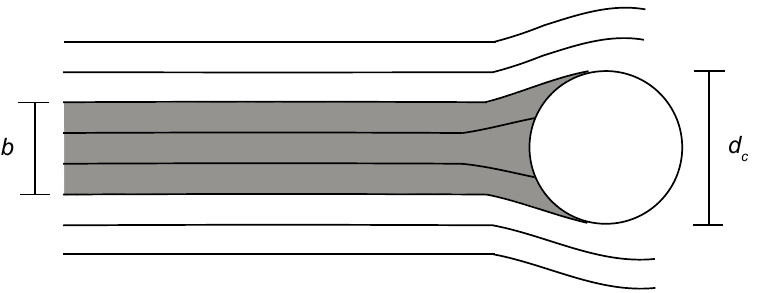
Figure 1. Plan view of the theoretical definition of capture efficiency, η , as the ratio of the effective width of the particle streamlines that will be intercepted by a collector, b , to collector diameter, d c . Modified from Palmer et al.